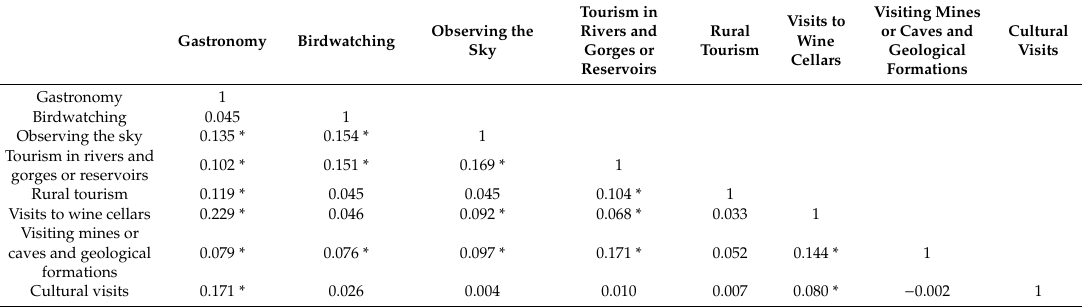
Table 6. Correlation array on the motivations of visitors to the geopark.